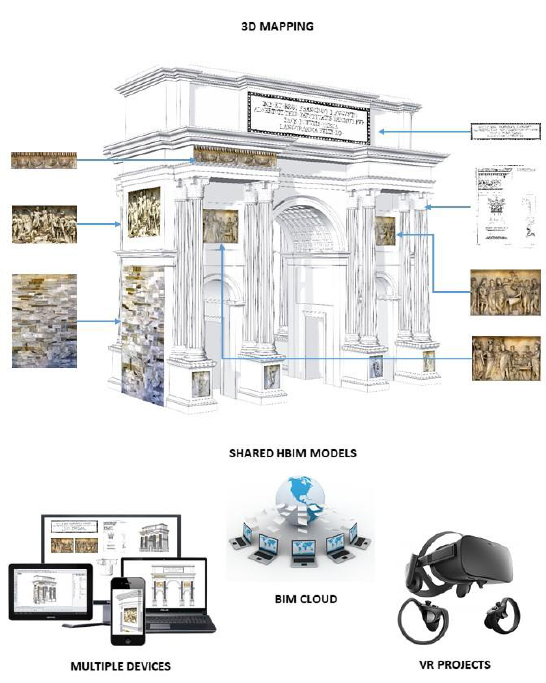
Figure 6. The generative process of the HBIM of the Arch of Peace in Milan. The ten GOGs have been applied to HBIM model to achieve the best level of detail (LOD), information mapping and information sharing of the historical monument.